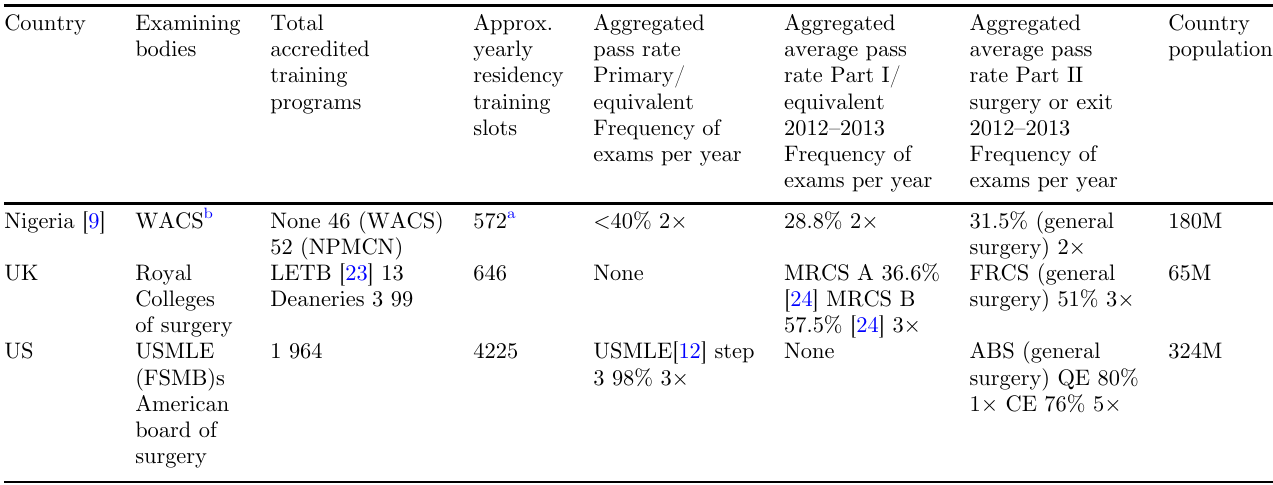
Table 3. Demographics of different stage of post graduate surgical exams [25 – 32].